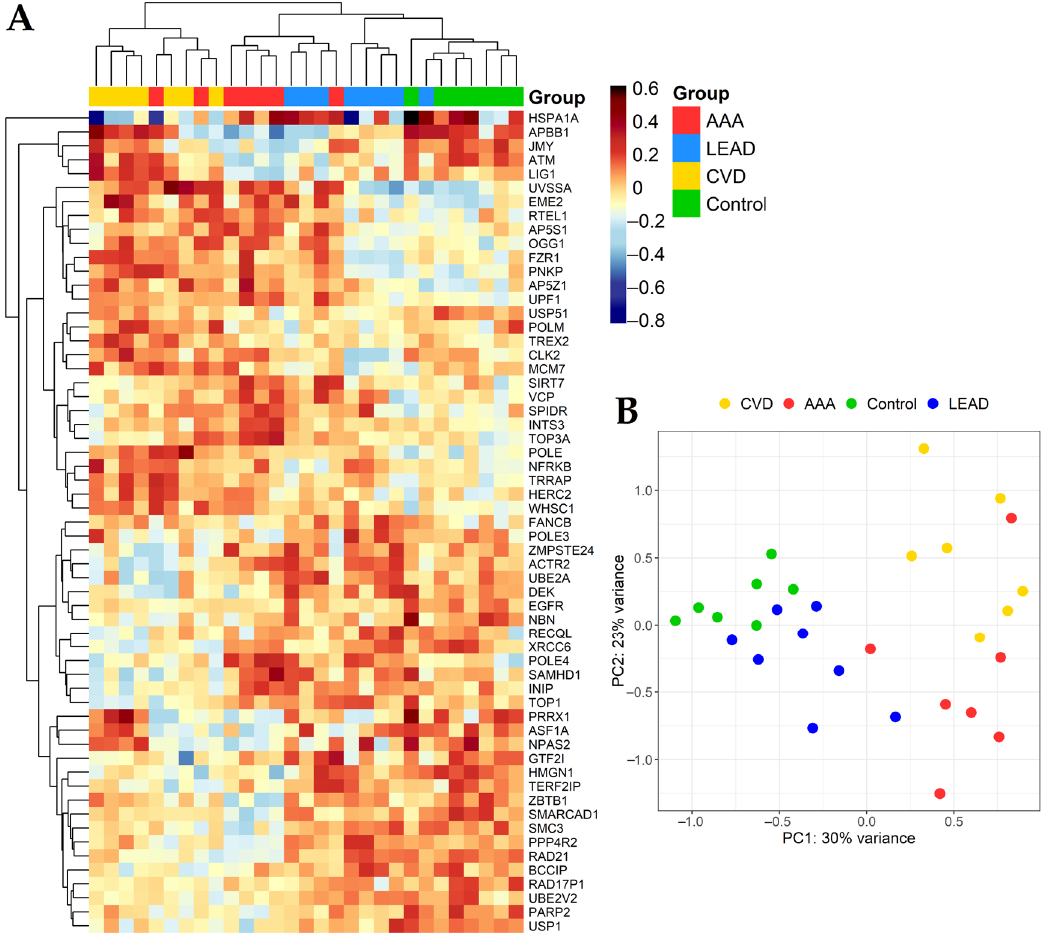
Figure 1. Differentiation in expression of genes selected from performed comparisons. ( A ) Heatmap with clustering of Euclidean distances using the complete method. ( B ) Principal component analysis (PCA) plot. LEAD—lower extremities arterial disease, AAA—abdominal aortic aneurysm, CVD— chronic venous disease, Control—healthy persons.